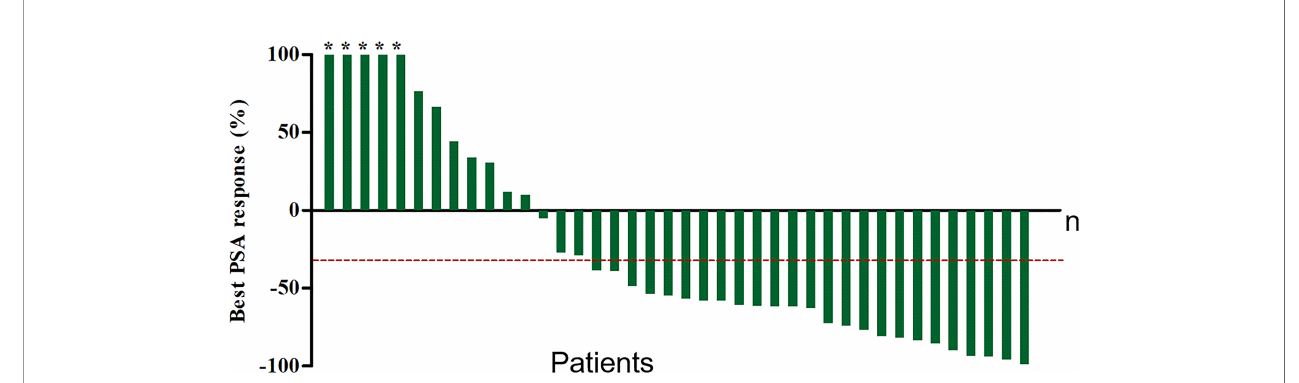
FIGURE 3 | Waterfall plot of best PSA decline compared with baseline. Plots ordered from worst to best responder. Red dotted line represents 30% PSA decline. *The maximum PSA decline >90%.